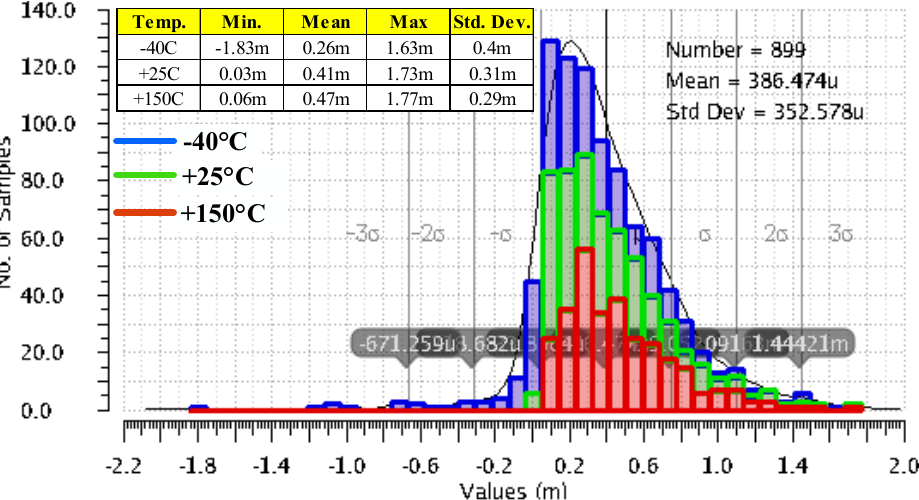
Figure 9. LDO PSR simulation results for three CL values (10 pF, 100 pF, and 400 pF) at extreme values for IL: 1 µA and 100 mA.